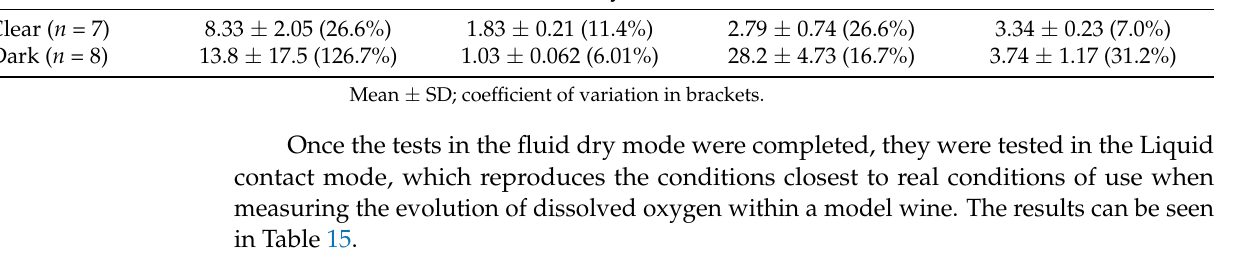
Table 15. Main permeation results of tested granite pieces in liquid contact